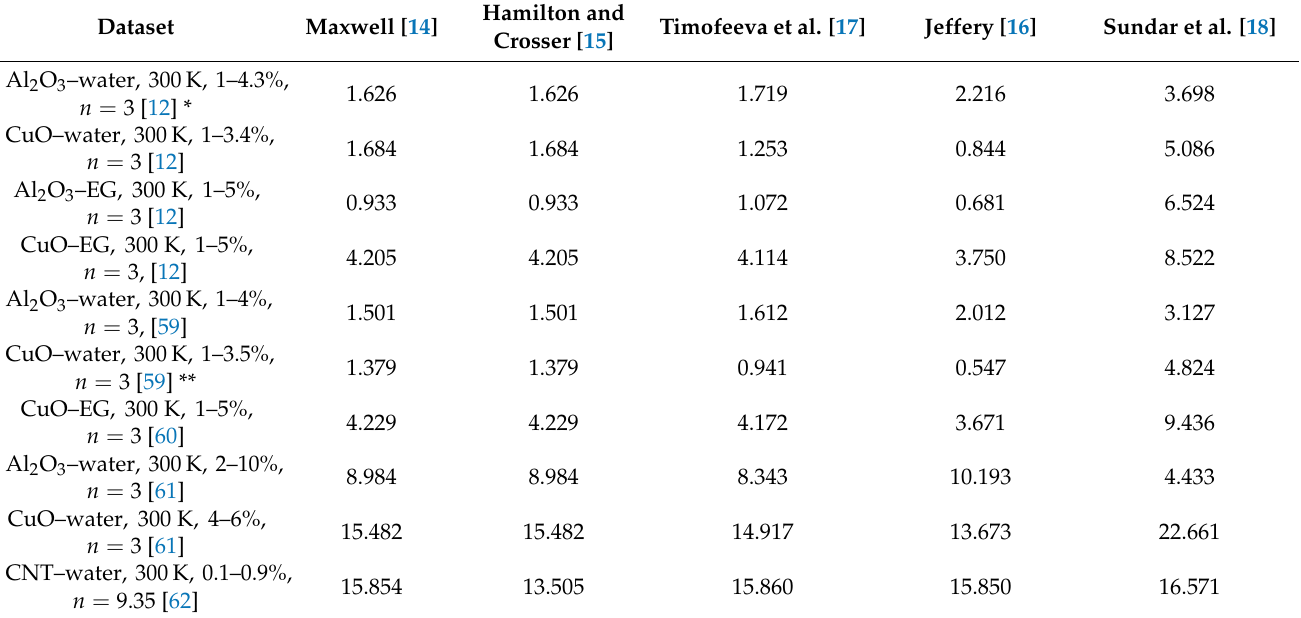
* Experimental data used in Figure 1; ** Experimental data used in Figure